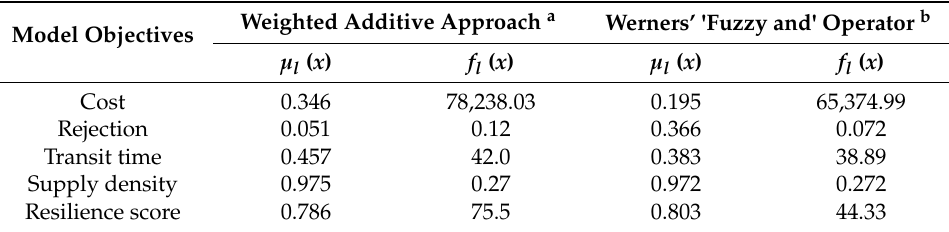
Table 6. Solution of a case example.